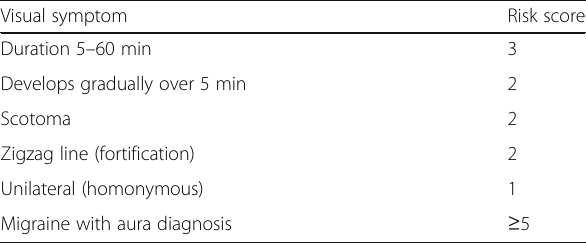
Table 7 Visual Aura Rating Scale (VARS) Visual symptom Risk